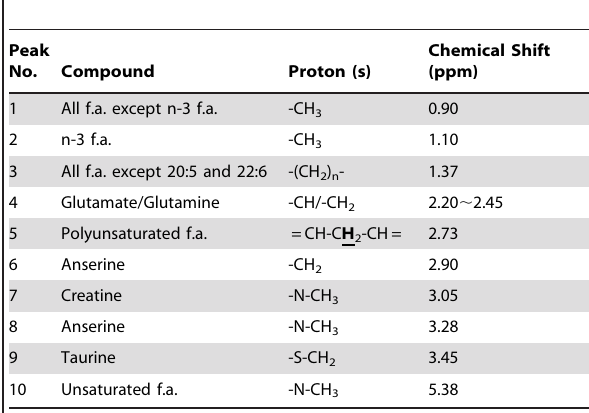
Table 3. Peak assignment for iMQC spectrum of intact Siamese algae